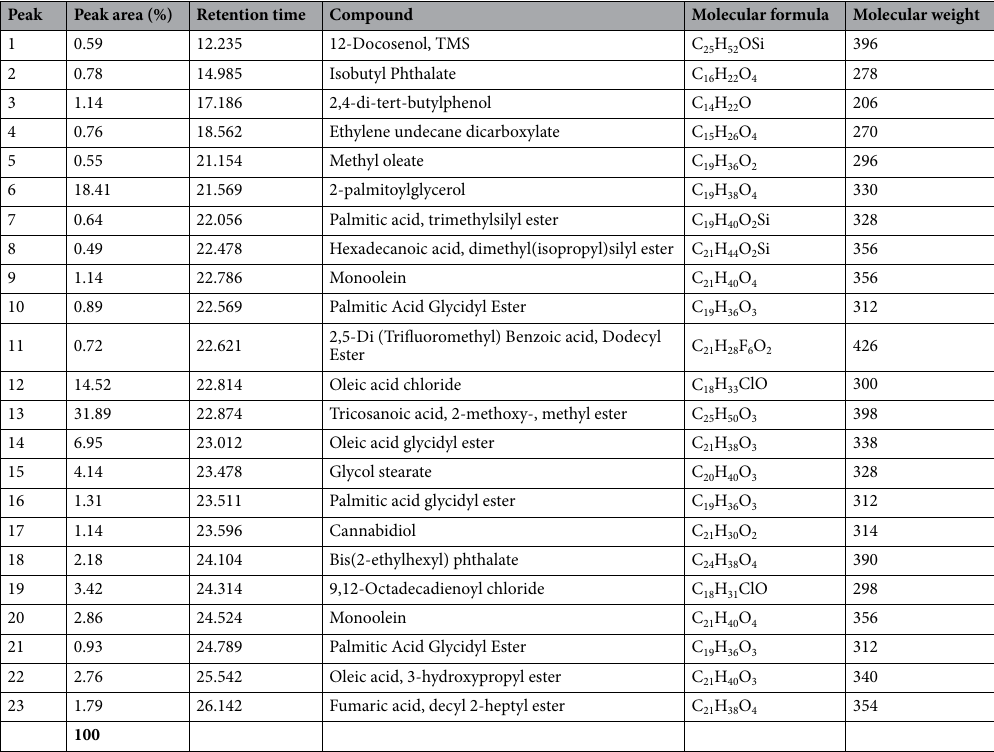
Table 2. GC–MS analysis of PB extract mediated